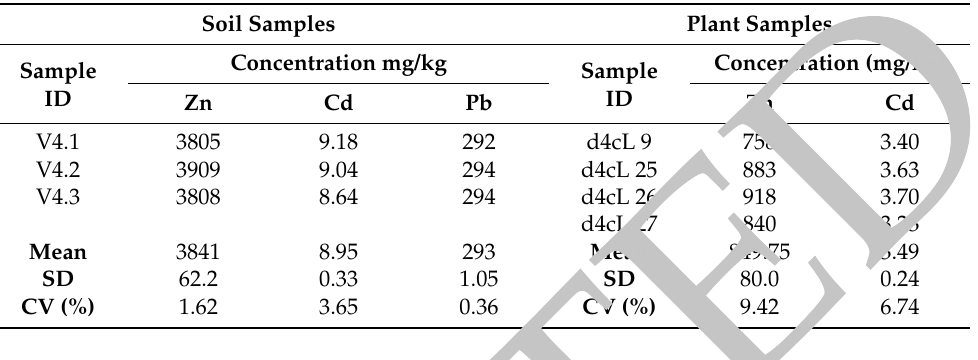
Table 3. Results from duplicate analyses to determine precision levels. Standard deviation (SD) is calculated using the range of values multiplied by 0.4. Precision within this study is expressed as ± two coefficients of variance (cv), i.e., at a confidence level of 95%. Plant sample Pb concentrations were below practical detection limits of the analytical procedure.